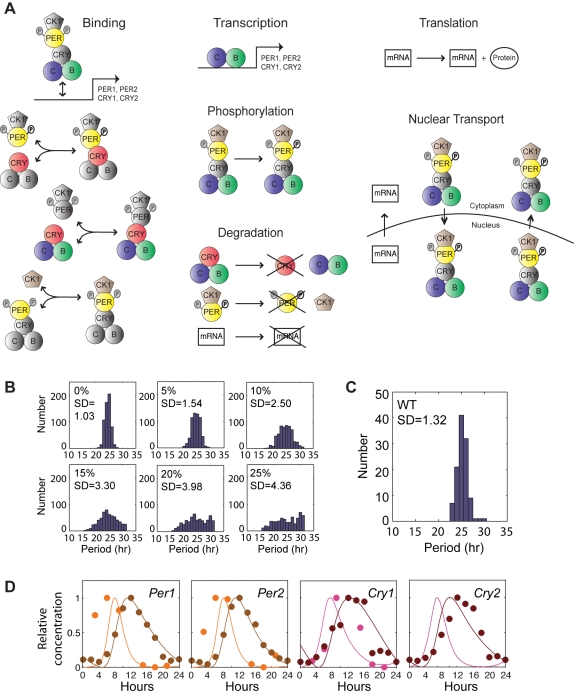
Illustration of the elements of the stochastic model of the cellular circadian clock and heterogeneity in period length.(A) The biochemical processes modeled in an SCN cell. The specific equations and rates are included in Figure S7 (see also Protocol S1). Gray components represent molecules that could be bound but have no effect on the indicated process. This model is based on the Forger-Peskin model [14] but contains three major improvements: (1) it allows for binding and unbinding of CLOCK:BMAL to Per1, Per2, Cry1, and Cry2 genes; (2) it allows interaction of CLOCK:BMAL with CRY1 or CRY2; and (3) it uses updated rates of degradation of mRNAs and proteins measured empirically by Siepka et al. [41]. (B) Histograms of average period length of 250 simulated single cells when the variation in biochemical parameters is within 0%, 5%, 10%, 15%, 20%, or 25% of the mean values of the rate constants. (C) Histogram of single-cell periods experimentally measured from dissociated WT SCN cells. The mean and standard deviation values from this experiment were used to select the best match of mean and standard deviation for the simulated cells; the simulated values were comparable to experimental values at 5% variation in rate constants. (D) Representative traces of relative concentration of Cry1/2 and Per1/2 mRNA and protein. Circles indicate experimental data from Lee et al. [11], and lines are stochastic simulations of a population of 100 cells using the model summarized in Figure 5A. Orange and pink traces represent mRNA levels (mRNA values for Cry2 were not reported in the original data). Brown and red traces represent protein levels.